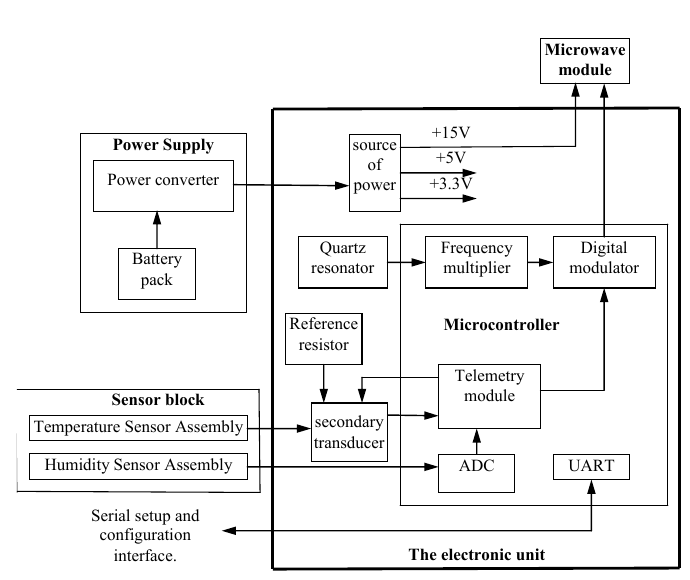
Fig. 7. Block diagram of ARS